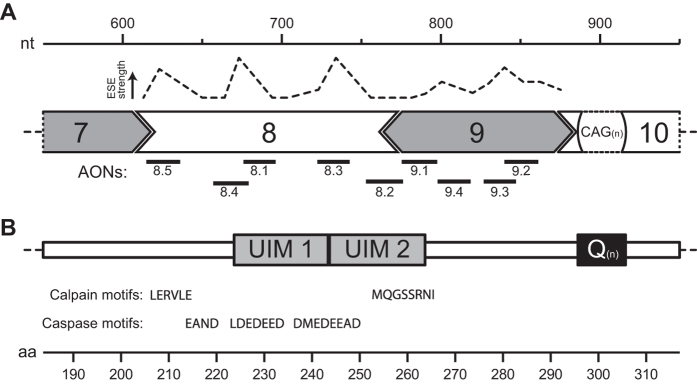
ATXN3 exon structure and predicted cleavage motifs of ataxin-3.Based on Ensemble transcript ENST00000558190. (A) Depicted is the exonic splicing enhancer signal (ESE) strength as predicted by the human splicing finder. The shape of exons represents the influence on the RNA reading frame. Location of designed antisense oligonucleotides (AONs) against exon 8 and 9 to promote exon-skipping are drawn to scale. (B) The corresponding ataxin-3 protein region contains ubiquitin interacting motifs (UIMs) 1 and 2. Predicted cleavage sites N-terminal of the polyQ tract as detected for calpain12 and predicted for caspases8 are shown (not to scale). nt = nucleotides, aa = amino acids.